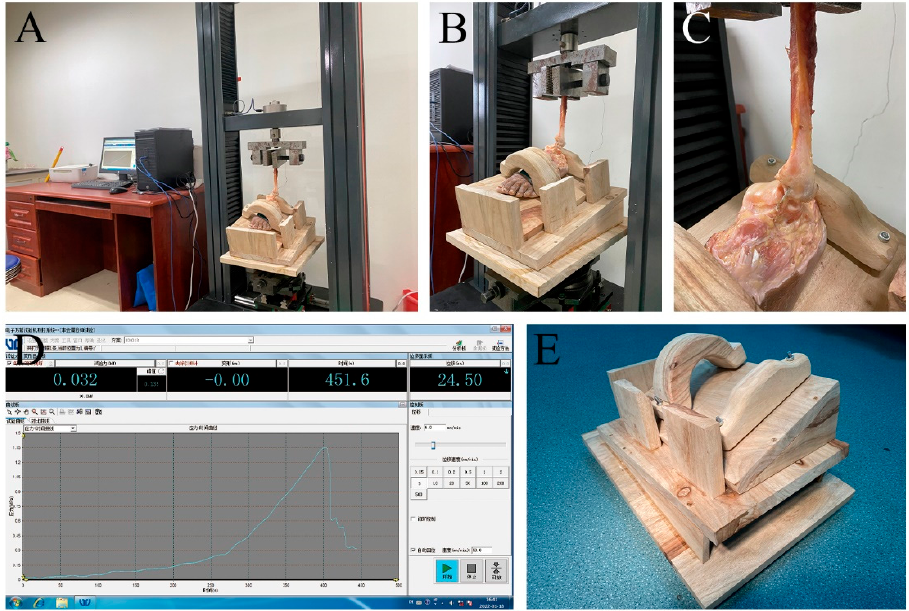
Figure 6. Pull-out experiment. ( A – C ): Schematic diagram of pull-out experiment. ( D ): Schematic diagram of software work. ( E ): Custom platform. diagram of software work. ( E ): Custom